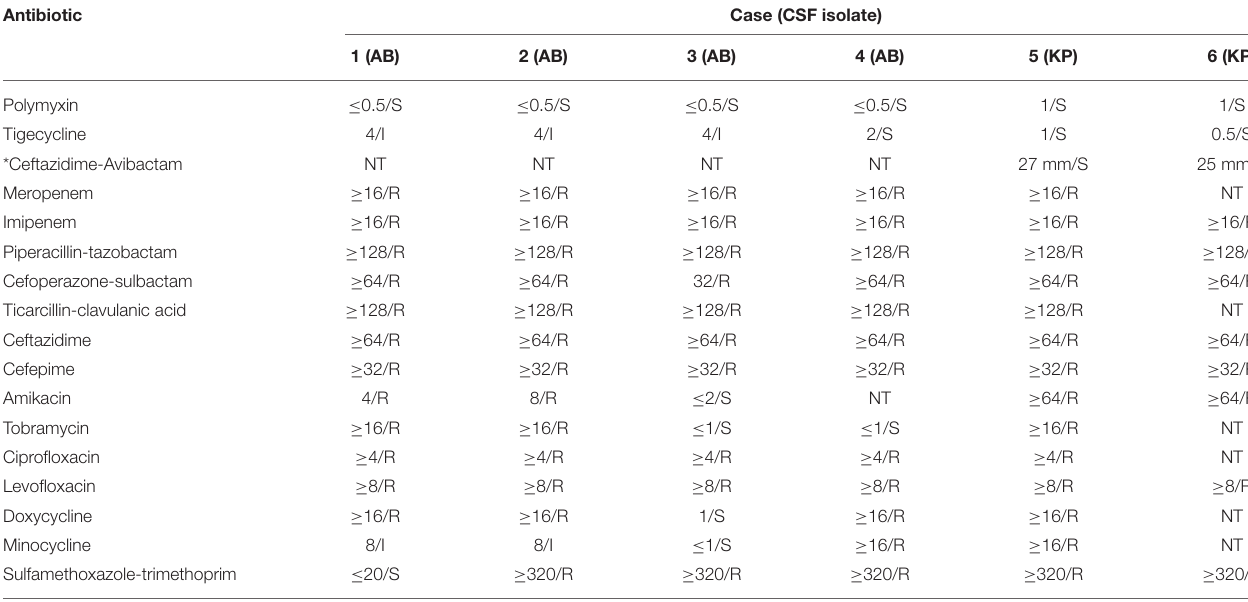
TABLE 1 | Antibiotic minimum inhibitory concentration (MIC, µ g/mL)/susceptibility of CSF isolates from patients enrolled in the study. Antibiotic